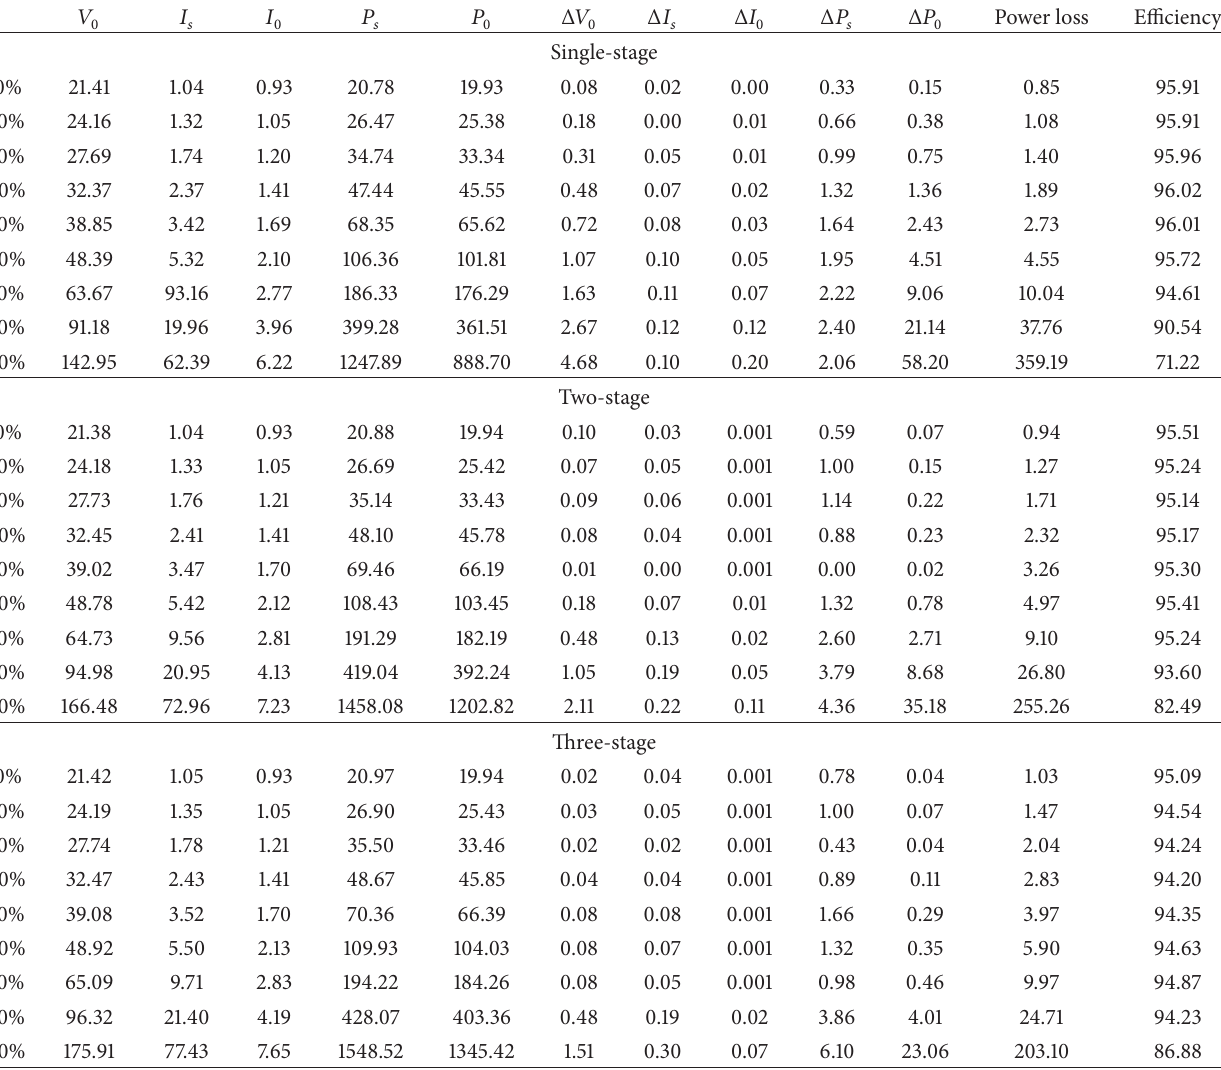
Table 5: Comparison of single, interleaved, and three-stage converters.